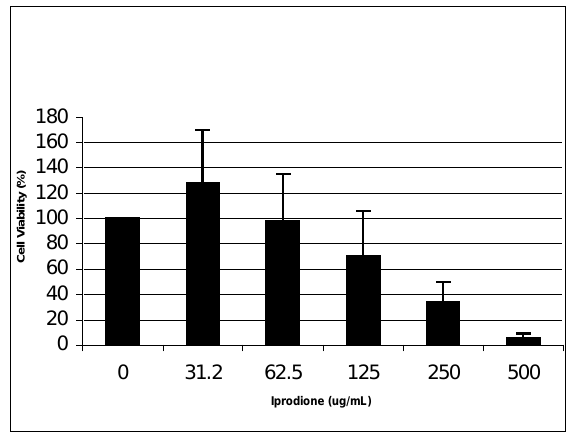
Fig. 1. Cytotoxicity of iprodione to HepG2 cells